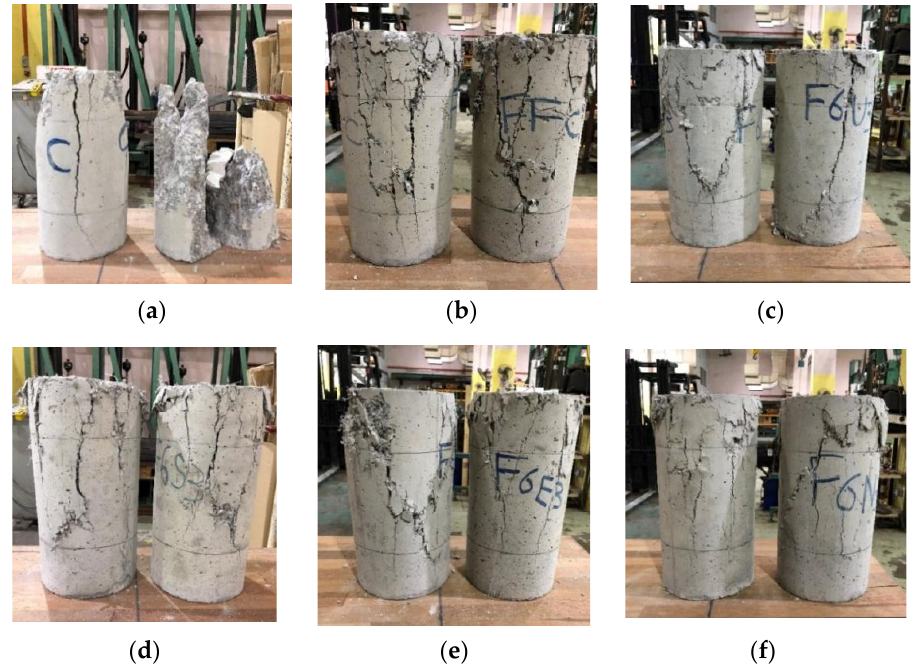
Figure 14. HyFRC damage in compression: ( a ) control, ( b ) FFC, ( c ) F6U3, ( d ) F6S3, ( e ) F6E3, ( f ) F6N3.